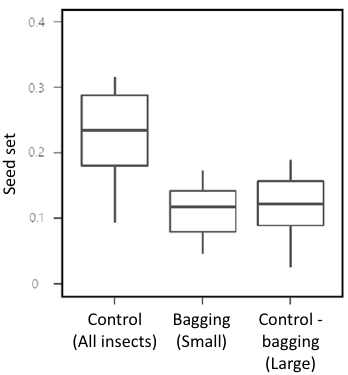
Figure 5. Seed sets of buckwheat (number of seeds/number of flowers) of control inflorescences (open to all insects), bagging inflorescences (only small insects had access), and the subtraction of bagging seed set from the control seed set. The three seed sets represent, respectively, the contributions of all insects, small insects, and large